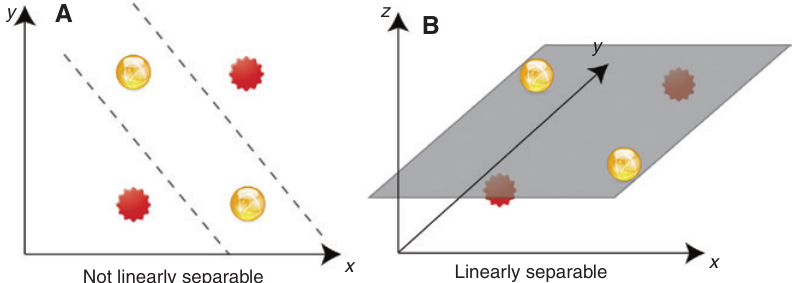
Figure 2: Illustration of the operation principle of reservoir computing. In its original ( x , y ) representation, two different classes of data cannot be linearly separated (left panel). Upon adding an additional dimension, ( x , y , z ) representation, a linear separation via a linear hyperplane can be found. Reservoir computing is based on the creation of additional dimensions to provide such hyperplanes. Figure adapted from Appeltant et al.